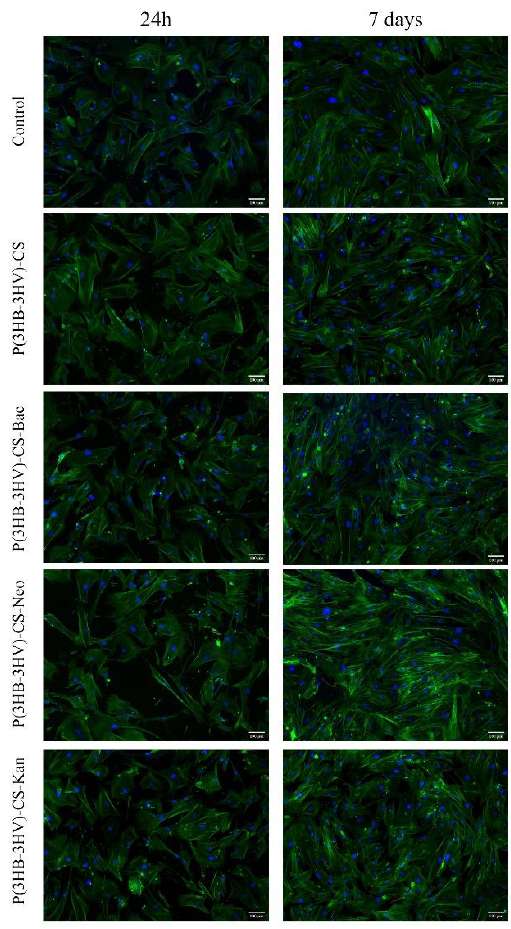
Figure 6. Fluorescence micrographs revealing the cellular morphology of the human dermal fibroblast treated for 24 h and 7 days with simple and Bac-/Neo-/Kan-loaded P(3HB-3HV)-CS spheres. F-actin filaments are stained with phalloidin-FITC (green) and nuclei are stained with DAPI (blue). Scale bar = 100 µm.